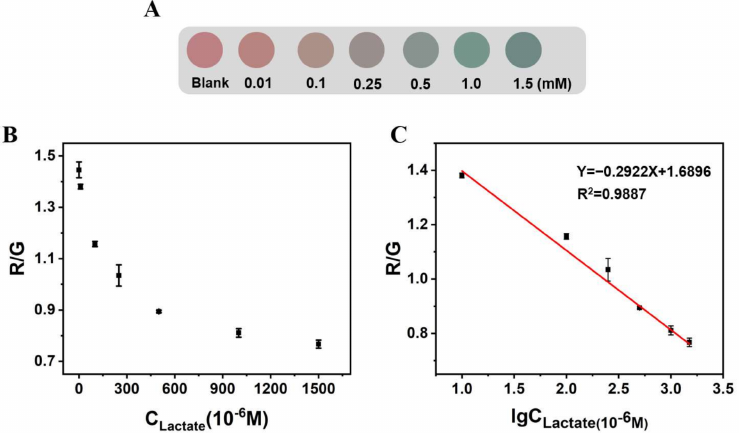
Figure 6. The influence of lactate on the fluorescence color and R/G value of Alg@PDCN@QDs- LOx MSs. ( A ) Influence of lactate on the fluorescence of microspheres. ( B ) The R/G value of Alg@PDCN@QDs-LOx MSs corresponding to different lactate concentrations. ( C ) Linear plot of the R/G value of Alg@PDCN@QDs-LOx MSs with respect to the logarithm of the lactate